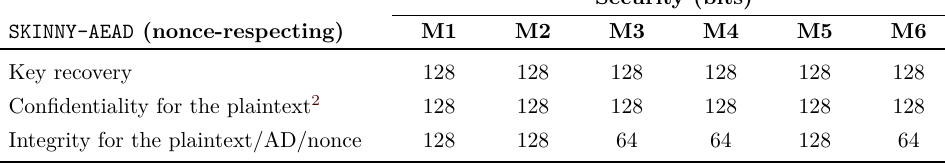
Table 5: Security claims of SKINNY-AEAD and SKINNY-Hash . The bit security of our designs is expressed in terms of calls to the internal primitive, up to a small logarithmic